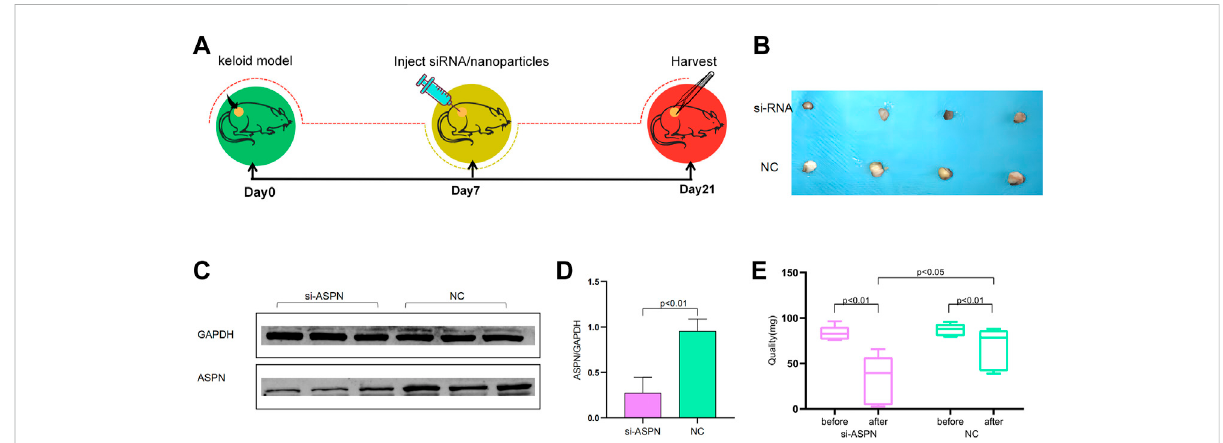
FIGURE 7 (A) Flow chart for in vivo experiments. (B) External morphological changes of the keloid before and after transplantation. (C,D) Western blot examined the expression of ASPN protein in tissues of the si-ASPN and NC groups and revealed that ASPN expression was signi fi cantly downregulated after 2 weeks of treatment ( p < 0.01). (E) Quanti fi cation of the external morphological changes of the keloid before and after